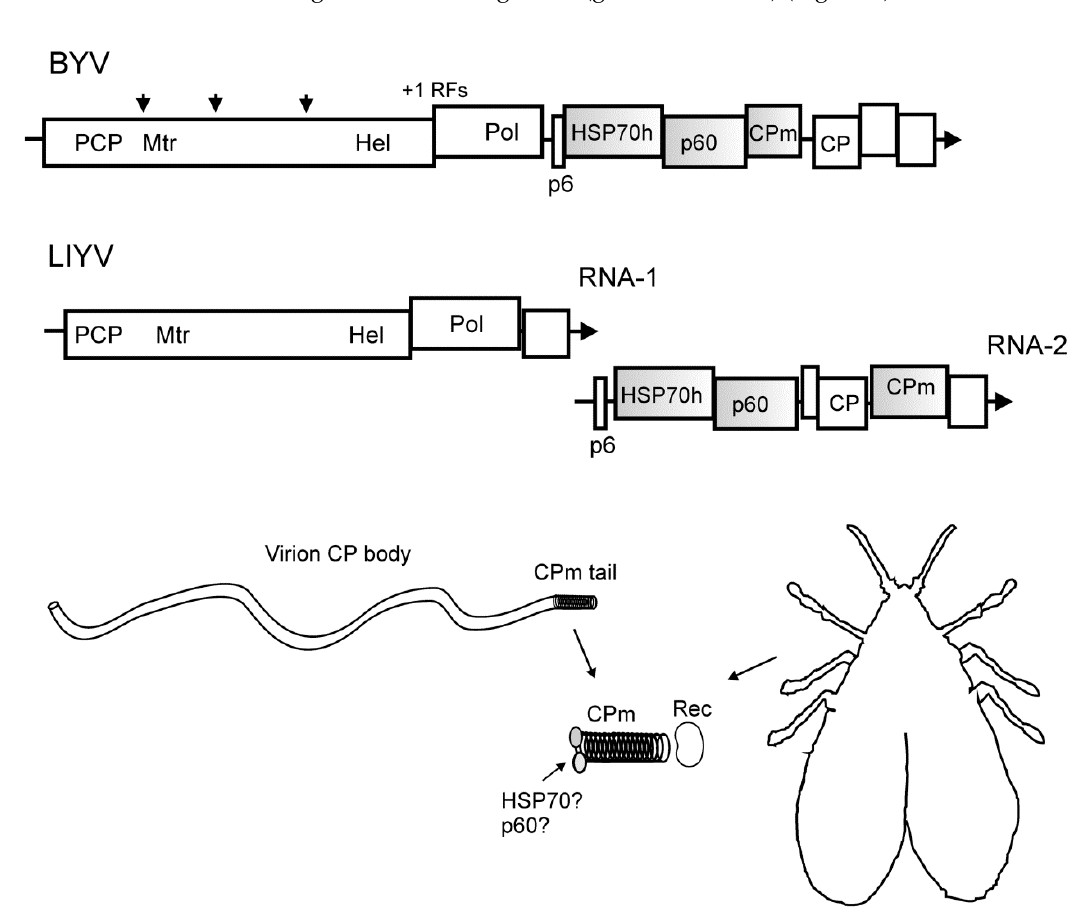
Figure 4. Top, scheme of the RNA genomes of beet yellows virus (BYV, genus Closterovirus ) and lettuce infectious yellows virus (LIYV, genus Crinivirus ) drawn approximately to scale. +1 RFs, +1 ribosomal frameshifting signal; arrowheads, cleavage sites in the polyprotein. Abbreviations for encoded protein domains: PLP, papain-like cysteine proteinase; Mtr, N7-guanosine methyltransferase; Hel, RNA helicase; Pol, RNA dependent RNA polymerase; p6, small hydrophobic protein; HSP70h, homolog of the cell HSP70 family of heat shock proteins; p60, ~60 kDa protein; CPm, minor capsid protein; CP, major capsid protein. Arrows indicate the 3 ′ -ends of RNAs. The genes for the capsid proteins are shown as shaded boxes. Bottom, schematic structure of the closterovirus particle with a CPm tail. Localization of the HSP70h and p60 in the virion is shown hypothetically. The CPm, with assistance of HSP70 and p60, interacts with a receptor in aphid (BYV) or whitefly (LIYVV) vector.